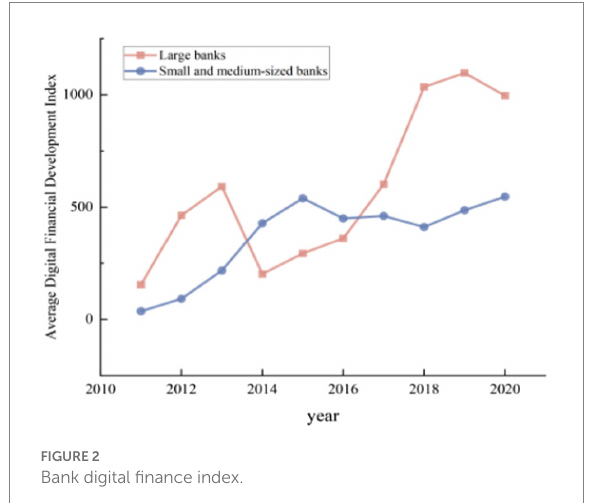
FIGURE 2 Bank digital finance index.